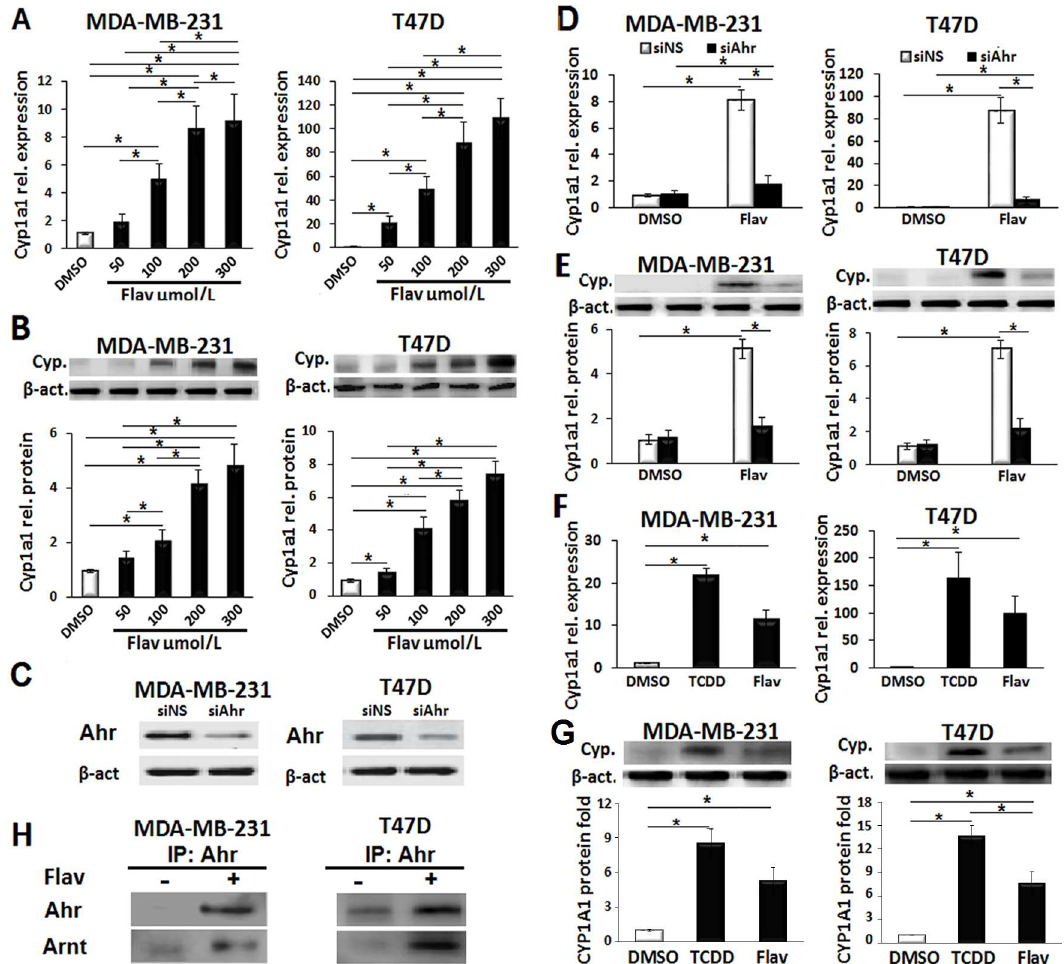
Fig 2. Flavipin induces Cyp1a1 gene expression in an Ahr-dependent fashion activity in breast cancer cell lines. (A, B) The mRNA and protein levels of Cyp1a1in MDA-MB-231 and T47D cells were elevated after treatment with Flavipin for 48 h. Quantification was performed by real-time PCR and western blot. (C) Confirmation of siAhr efficiency in breast cancer cells. (D, E) The siAhr inhibitedthe increasein Cyp1a1mRNA and protein inducedby Flavipin (200 μ mol/L). (F, G) Comparisonof Cyp1a1gene expressionin response to TCDD or Flavipinin MDA-MB-231 and T47D cells. (H) Flavipin inducedAhr/Arnt complex. Immunoprecipitation (IP) using Ahr antibodies was performed and precipitated Ahr and Arnt were detected by western blot. Data are shown as mean ± SD from representative experiment studied in triplicates. * P <